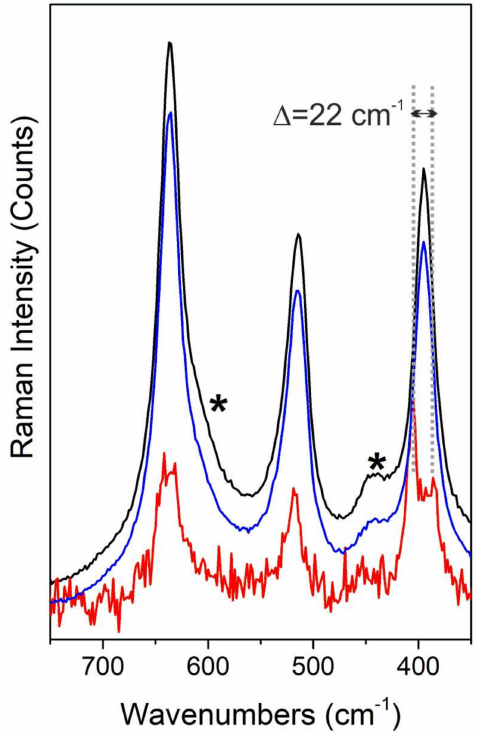
Figure 2. Raman spectra, acquired with a 442-nm laser line, of: TiO 2 used as a reference material (black line), sulfided TiO 2 (blue line) and MoS 2 /TiO 2 (red line) samples. Raman fingerprints of rutile are marked by